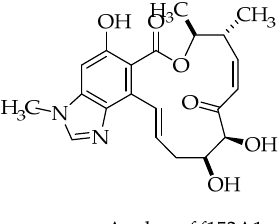
and showed good therapeutic effects in arthritis [56].